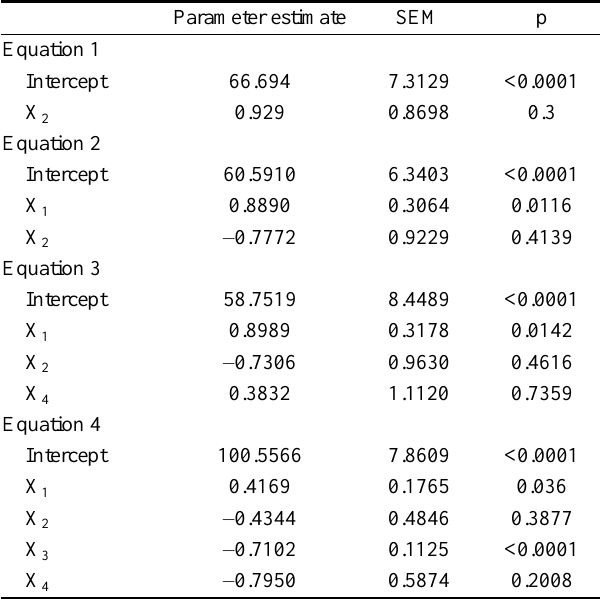
Table 7. The a correlation matrix of correlative coefficients